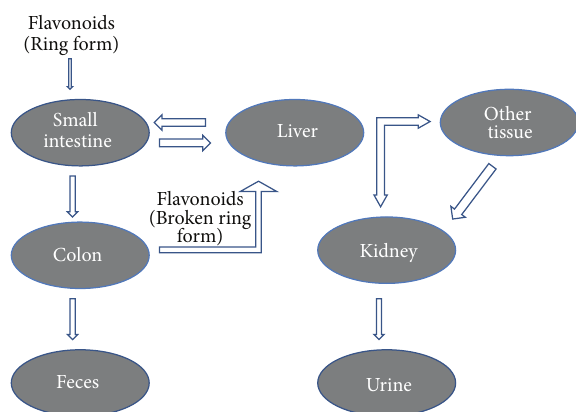
Figure 3: Compartments involved in the metabolism of